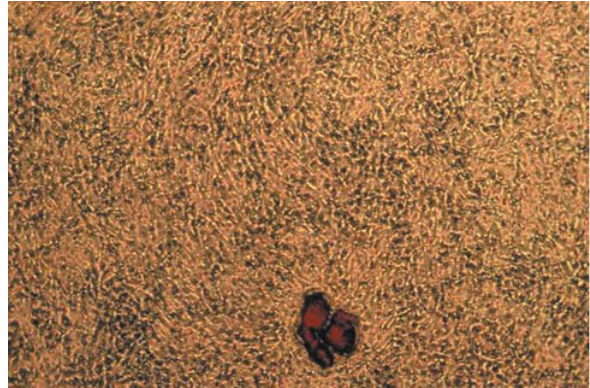
FIGURE 2- Photograph showing the formation of a bone nodule stained with Alizarin red S in an osteo-1 cell culture at 21 days